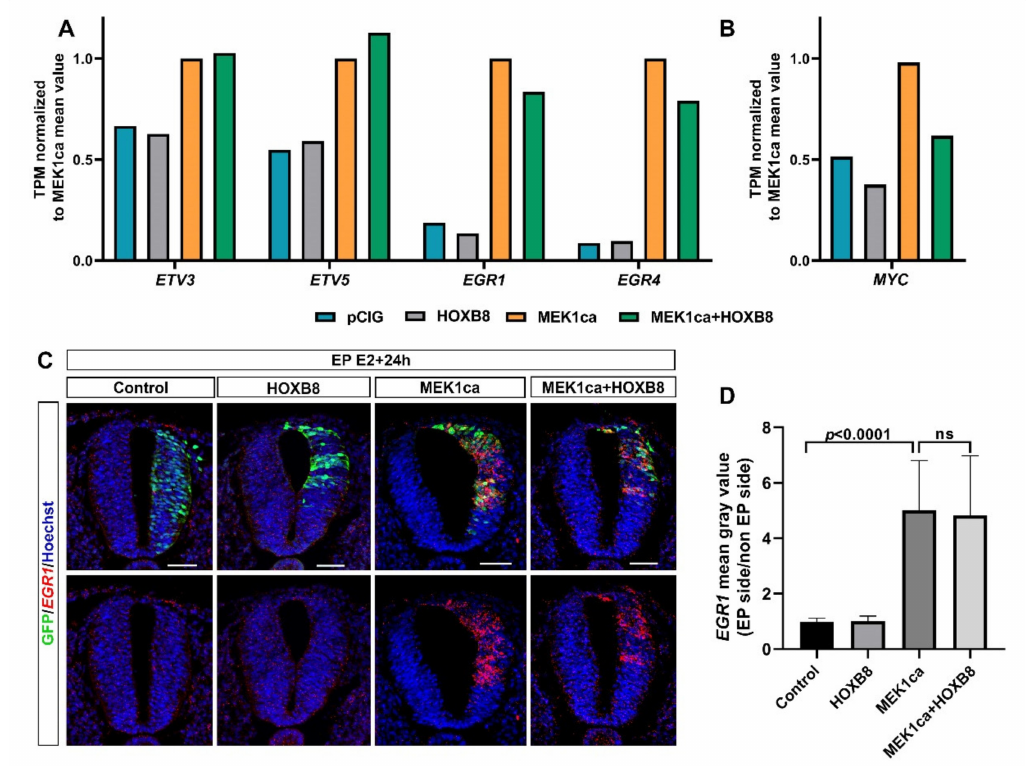
Figure 5. The MEK1ca-induced ETV and EGR gene expression is not reversed by HOXB8. ( A , B ) Mean expression in TPM (transcripts per kilobase million) normalized to the MEK1ca value for pCIG, HOXB8 and MEK1ca + HOXB8 (mean of the two replicates of each condition) for the ETV3, ETV5, EGR1 and EGR4 genes ( A ) and the MYC gene ( B ). ( C ) Fluorescence in situ hybridization with the EGR1 probe and immunofluorescence staining with the anti-GFP antibody on transverse trunk sections of chicken embryos one day post-electroporation in the pCIG, HOXB8, MEK1ca and MEK1ca + HOXB8 conditions. Blue is Hoechst staining. Scale bar: 50 µ m. ( D ) EGR1 expression ratio (electroporated/contralateral side) one day after electroporation in the four conditions ( n = 3 animals/18 sections). The quantifications show that HOXB8 does not reverse MEK1ca-induced EGR1 expression (two-tailed Mann–Whitney test, error bars represent the